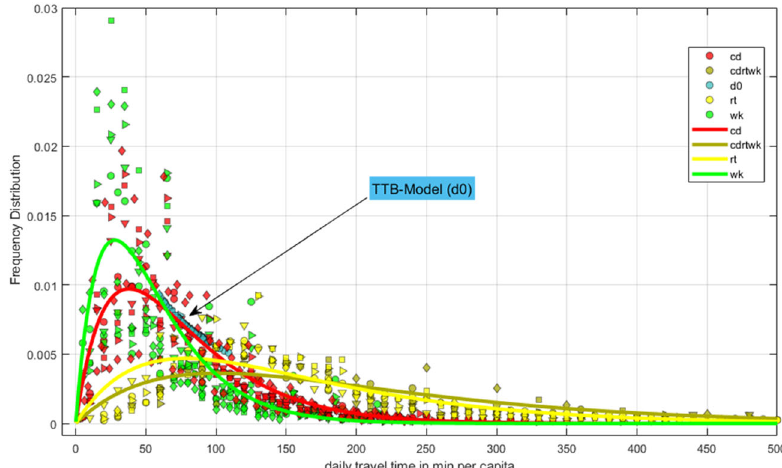
Fig. 2 Travel time and distribution function. A comparison of daily modal travel time distributions per capita between the relative frequencies of the raw data (individual markers) and the exemplary distribution function (continuous lines) of the proposed mobility model.